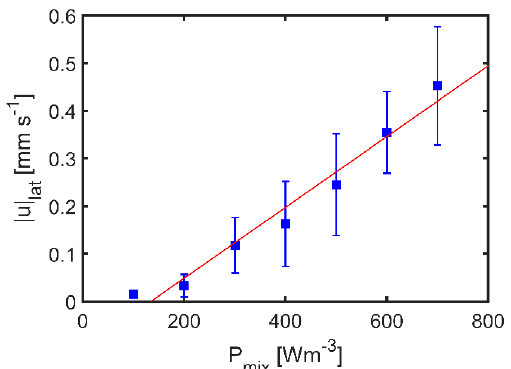
Figure 10. Lateral fluid velocity | u | lat as a function of volumetric power input P mix with error bars showing the standard deviation ± σ in a triplicate. Mixing was done in GB-MBR with S = 60 ◦ at a frequency of f = 148 Hz. The data were fitted by a linear function | u | lat = m · P mix − | u | 0 , with m being the proportionally constant and | u | 0 being the y-shift.